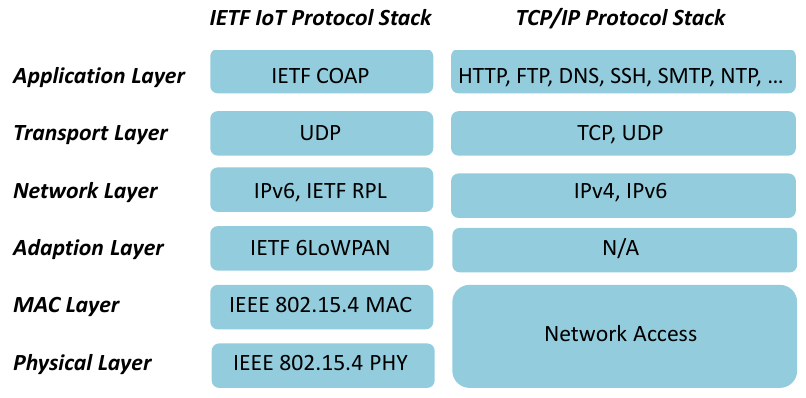
Figure 2. The comparison between IETF IoT and TCPIP protocol stacks.